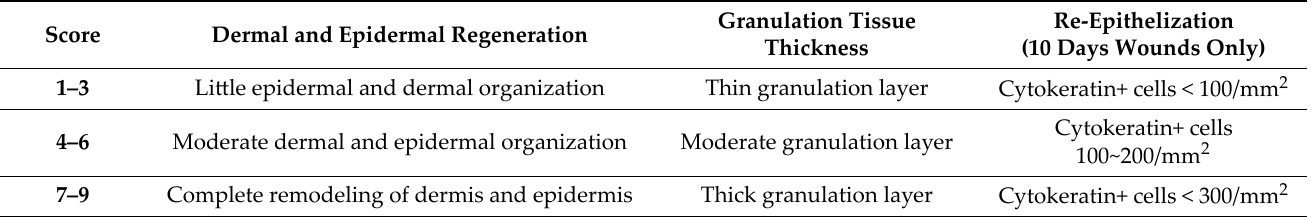
Table 1. Criteria for histological